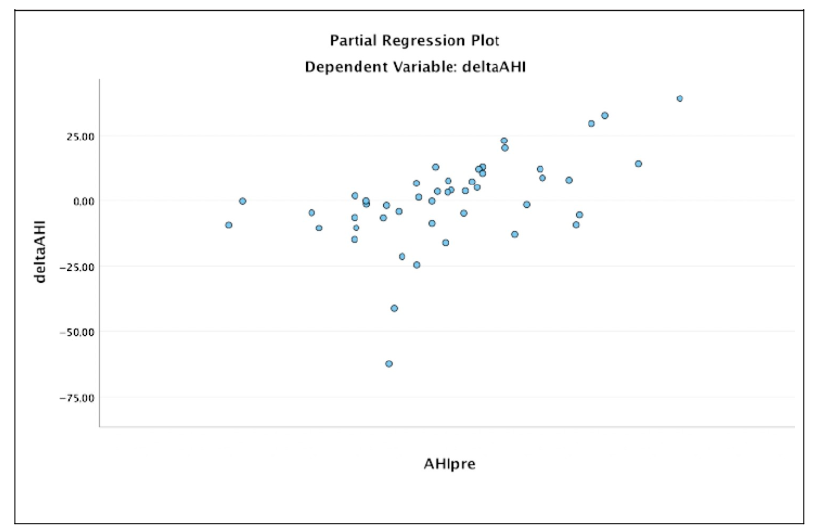
Figure 2. Linear regression graphs showing the relationship between preoperative AHI and delta ‐ AHI.